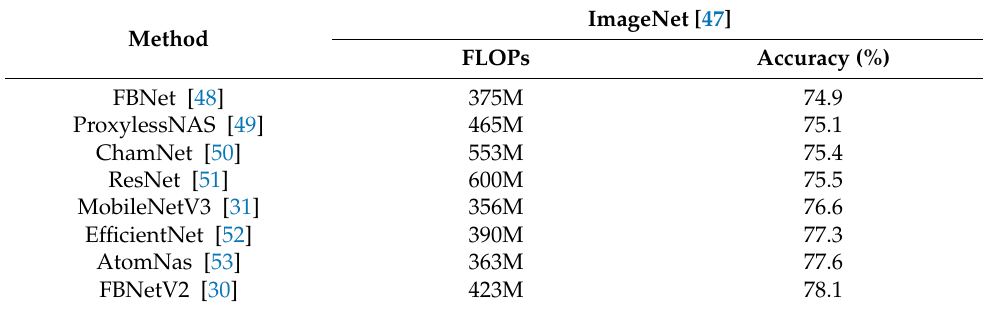
Figure 4. A presentation of some images of our multi-category portrait matting dataset (MPMD). Table 1. Comparisons of different methods on ImageNet.